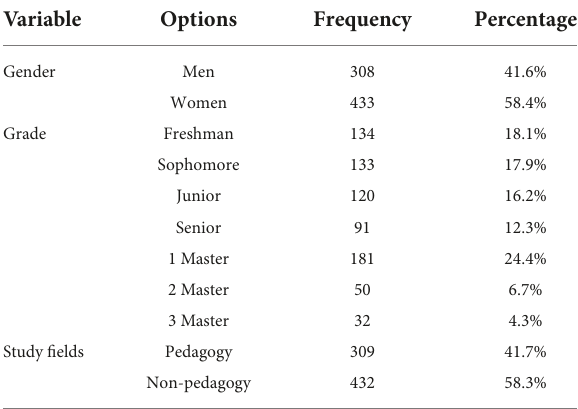
TABLE 1 Descriptive statistics of specific demographic